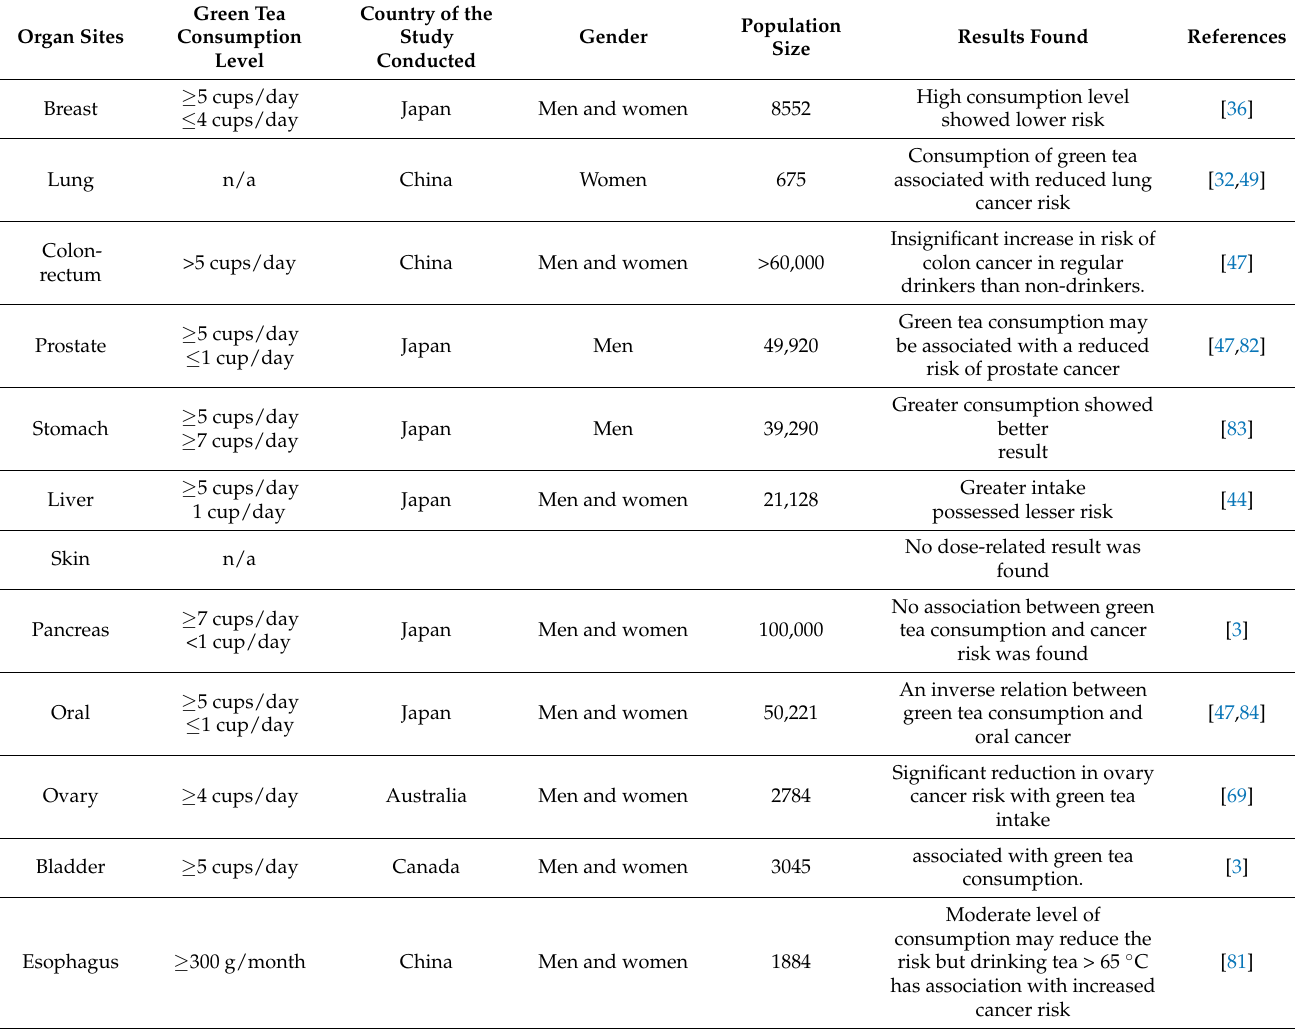
Table 3. Epidemiological studies of the relationship between green tea consumption and human cancer